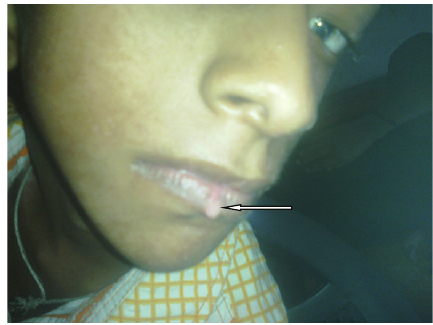
Figure 2: Raspberry-like papilloma present on lower lip.